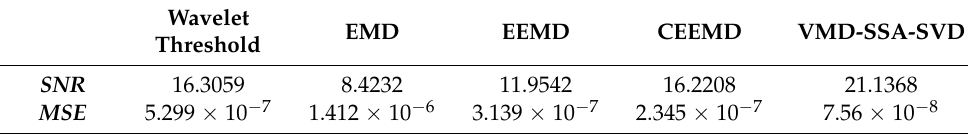
Table 3. The SNR and MSE of signals denoised by the five methods are shown in Figure 9.